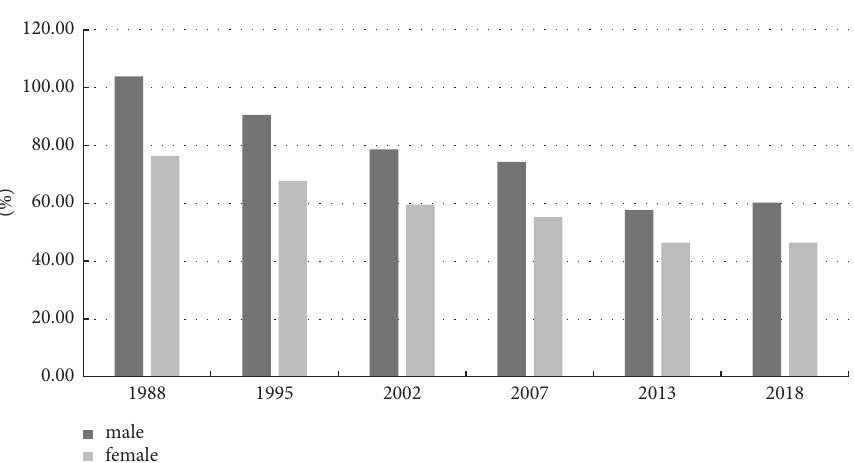
Figure 4: Pension security levels of males and